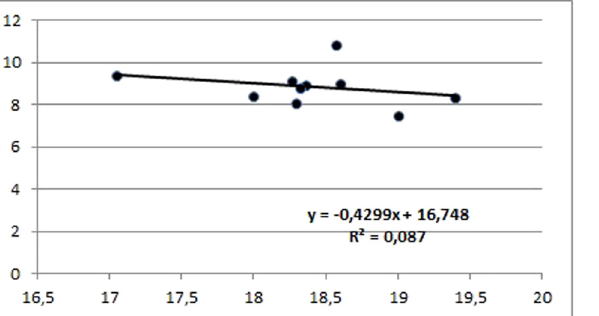
Figure 2: Linear approximation of the dependence of meat content on fat content in the cervical - scapular third of the carcass at a pre - slaughter weight of 120 kg.